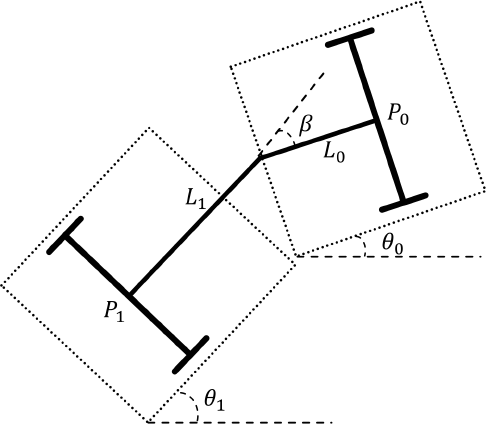
Figure 8. Articulated truck model for kinematic modeling. Coordinate frames for the multibody decomposition of the articulated truck is